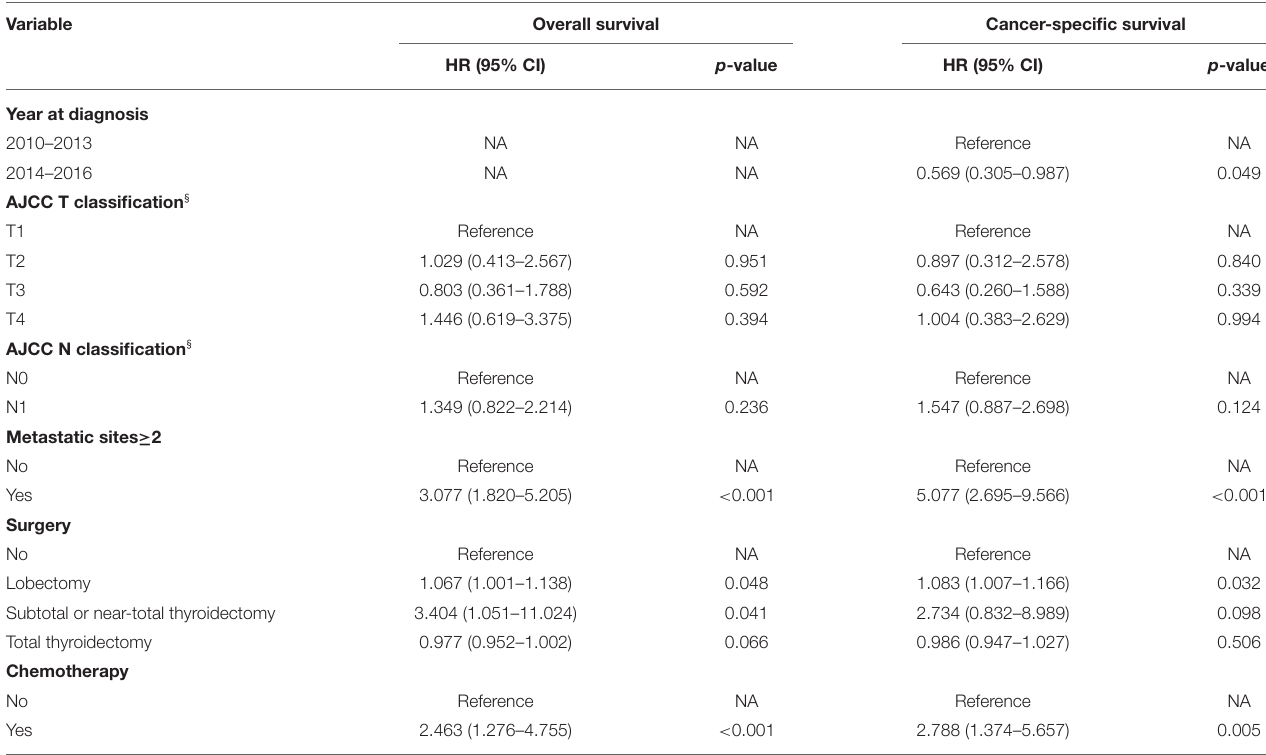
TABLE 3 | Multivariable analysis for OS and CSS in patients with DTC diagnosed with SBM. Variable